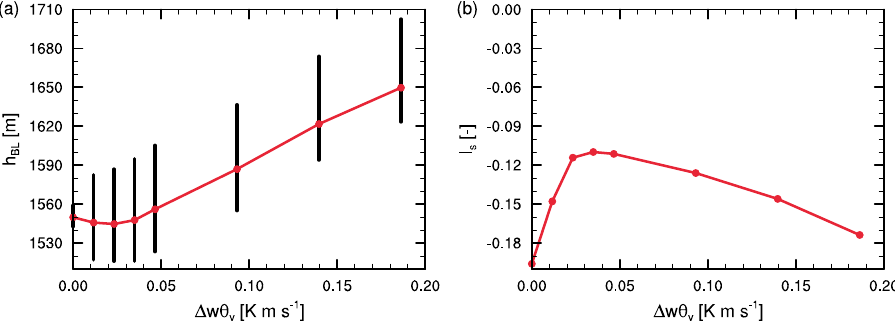
Fig. 13. Dependency of the boundary layer height (a) and the intensity of segregation in the boundary layer for Reaction (R9) (b) on the difference in surface buoyancy flux between forest and savannah areas. The plotted variables are averages over the fourth hour of simulated time. The boundary layer heights are additionally averaged in the x-direction. The values on the bottom axis are equal to − w 0 θ 0 w 0 θ 0 v v Isoprene , forest . In (a) the black vertical lines represent the variability in the hourly averaged boundary layer height in the savannah